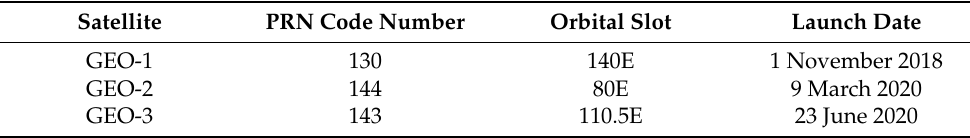
Table 1. PRN codes and orbital slots of BDSBAS GEOs [31].